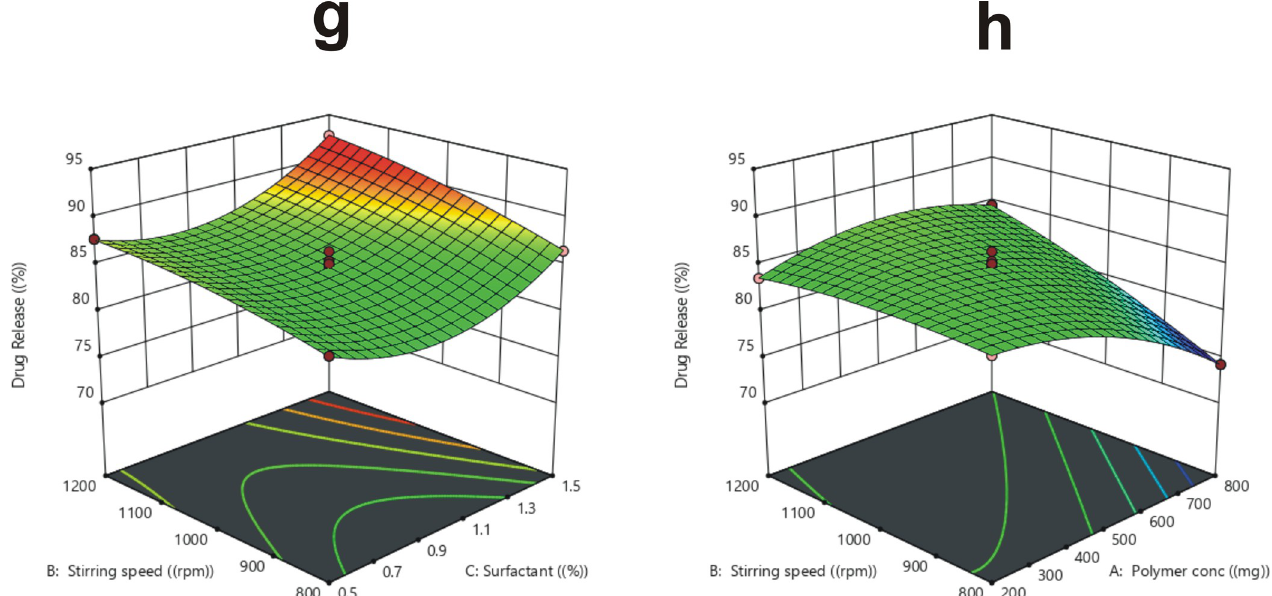
Fig 5. The influence of stirring speed and surfactant concentration on in vitro drug release (g), the influence of stirring speed and polymer concentration on in vitro drug release (h).